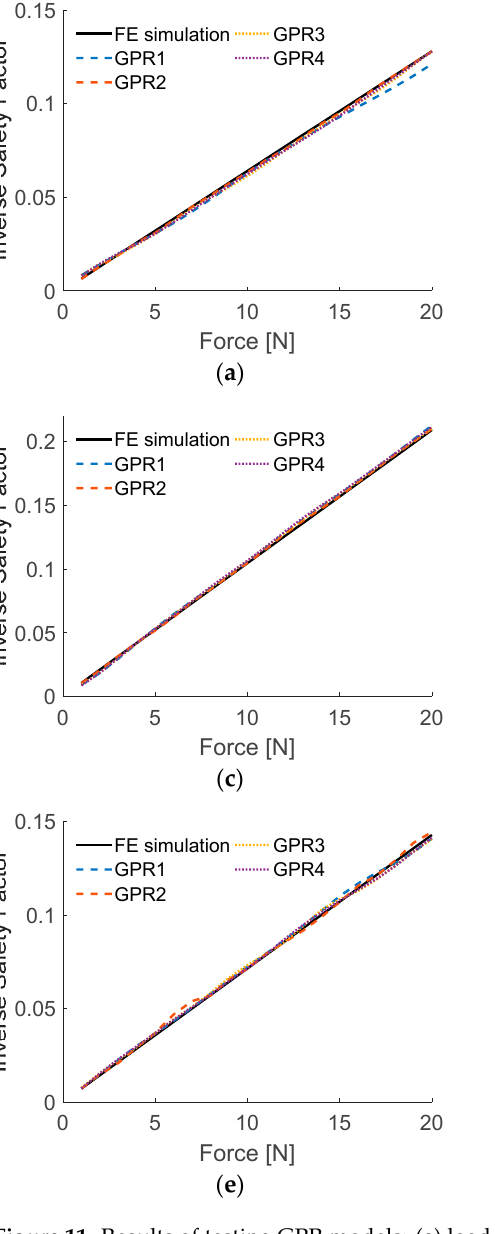
Figure 12. Graphical comparison of accuracy and computational time for obtained GPR models.